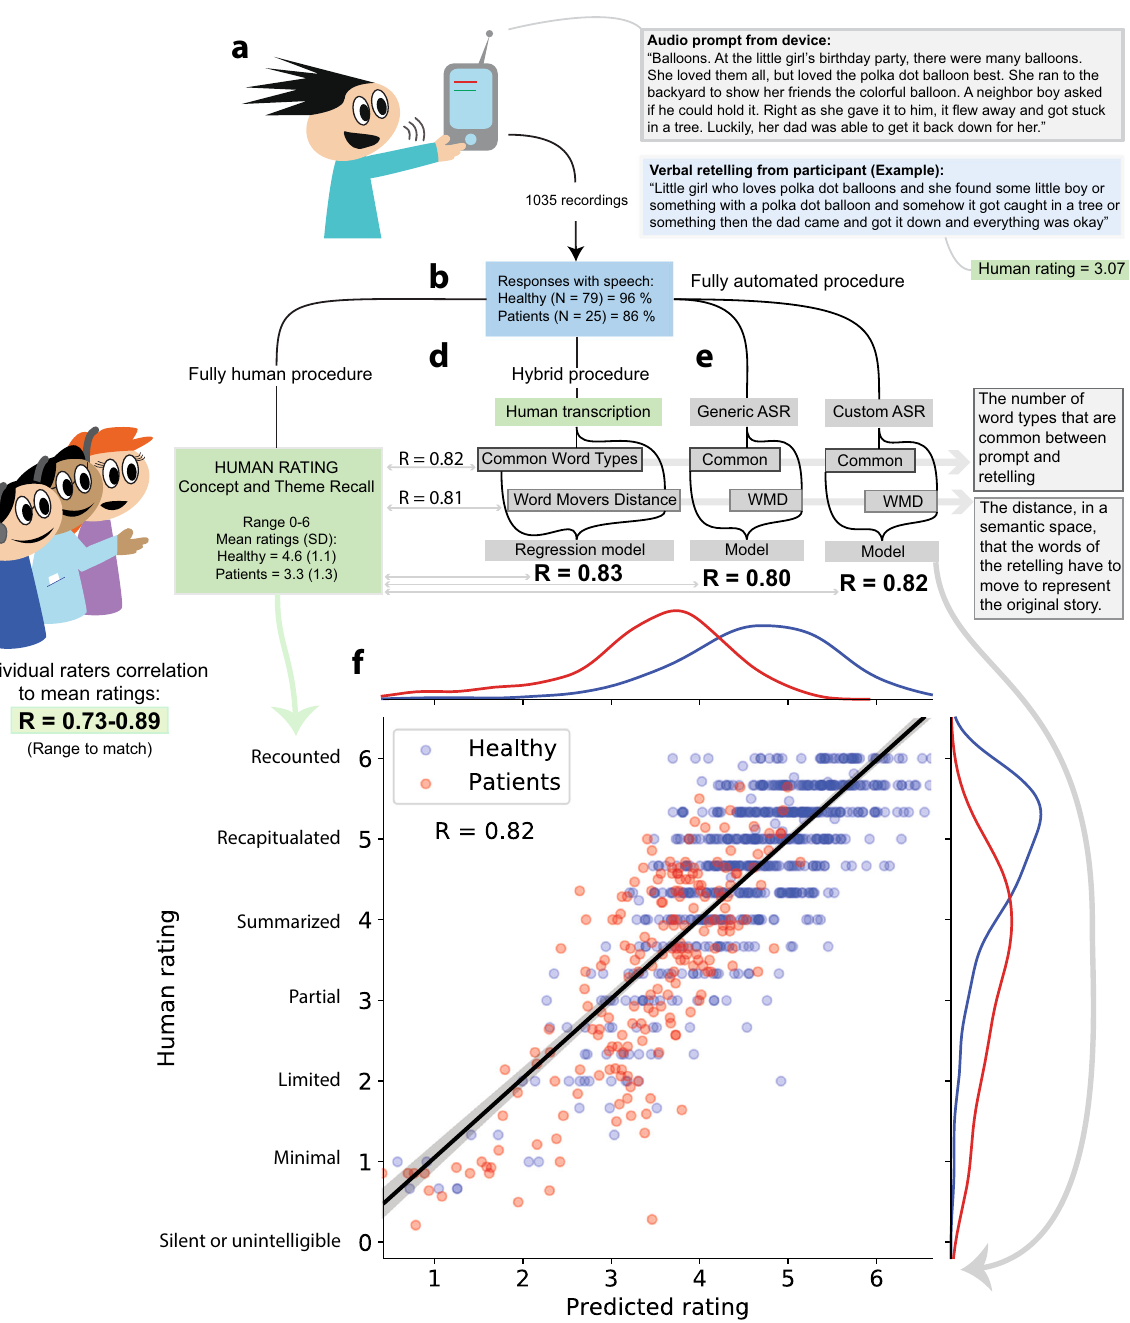
Fig. 1 A summary of the procedure for administration and analysis of verbal memory using smart devices. a In this example, a story was presented about a girl and her balloons at a birthday party. The participants were asked to “ Remember the balloon story, so you can retell it again later ” , and both immediate and delayed recall was assessed. b A total of 104 participants were tested. Patients tolerated the task but had more trials where they did not provide verbal responses. c Humans listened to the responses and rated them for accuracy on a scale between 0 and 6. Our ground truth measure was the average of multiple ratings, and the individual raters correlated with this ground truth between R = 0.73 and R = 0.89. d Humans transcribed the response recordings, and the similarity of these transcriptions to the original story was compared. Two features of similarity were extracted, namely a word count procedure and a measure of distance in a semantic space. A regression model produced predicted ratings, and these correlated with average human ratings at R = 0.83, well within the range of individual human raters. e The same computational procedure was used on transcripts derived using generic and customized automatic speech recognition systems. The performance of the automated predictive model was still within the level of individual raters with predicted scores correlating with the average human ratings at R = 0.82. f A linear model based on transcriptions from the custom ASR system predicted the human ratings well, except for a tendency to assign a higher score to some short